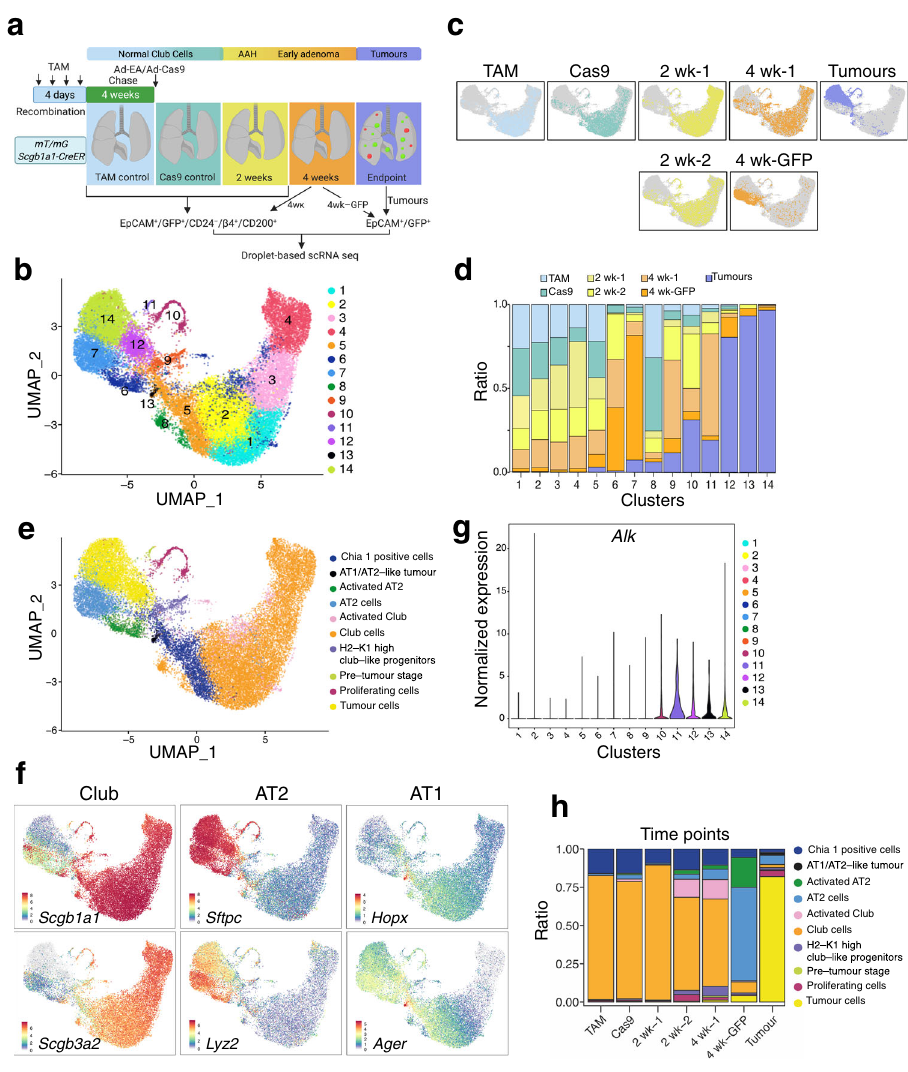
Fig. 5| Single-cellRNAsequencing.a ExperimentalstrategyofscRNAsequencing analysis. b UMAP of the high-quality cells. Cells are coloured by the clusters iden- ti fi ed using a shared nearest neighbour (SNN) modularity optimization-based clustering. c UMAPembeddingshowingthedistributionofthecellscollectedfrom the different time points. Coloured dots represent the cells collected at the indi- catedtimepoint;greydotsrepresentcellsfromtheothertimepoints. d Percentage of cells in each cluster, coloured by sample origin. The relative contributions were normalizedtothenumberofcellsineachsample. e UMAPcolouredbythecell-type